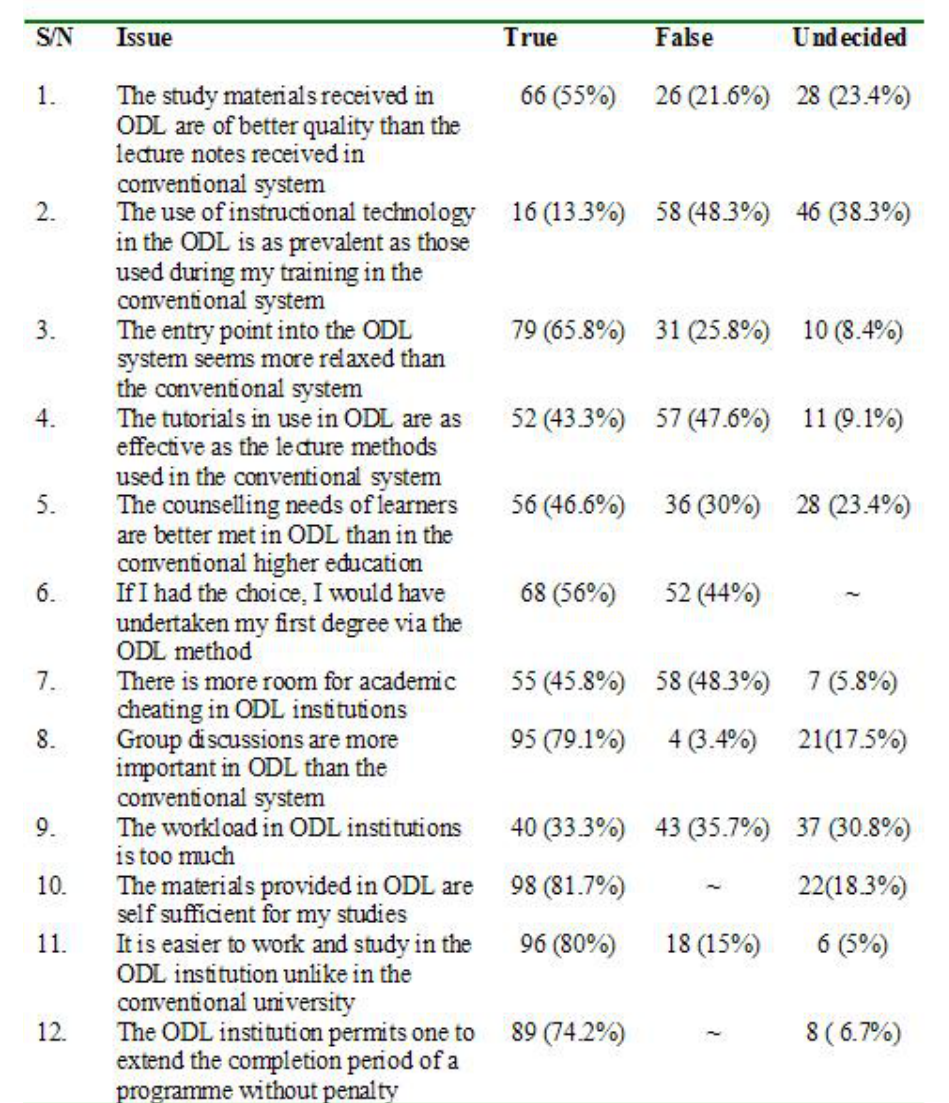
Table 3. Results of the